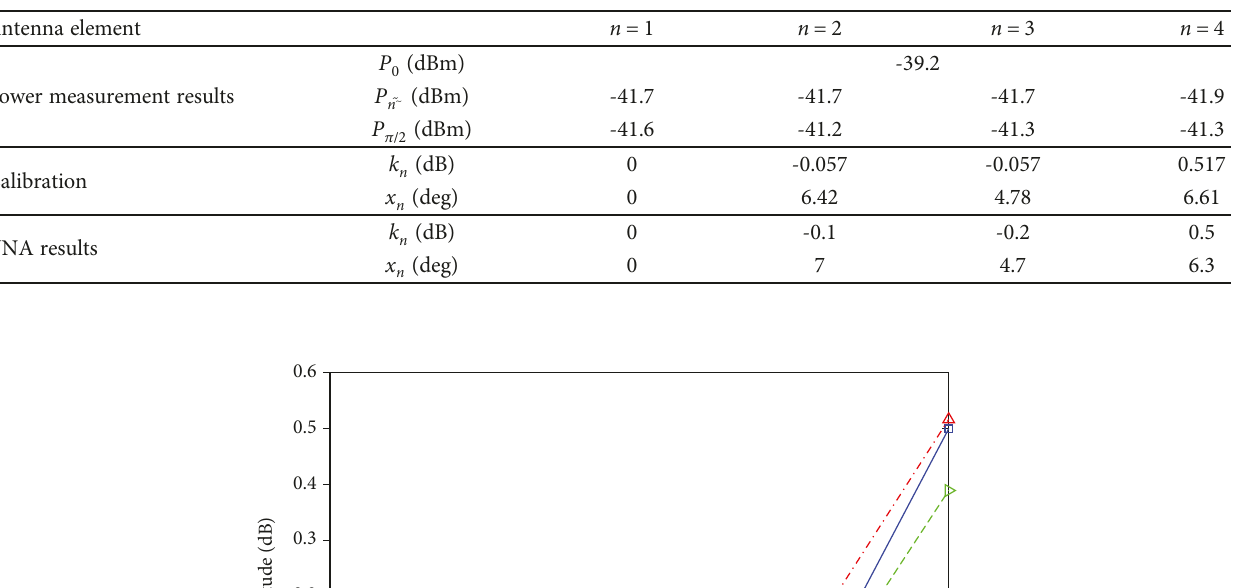
Table 1: Calibration results of the four-element patch antenna array.